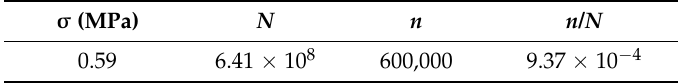
Table 8. Mechanical and physical characteristics of pavement materials.